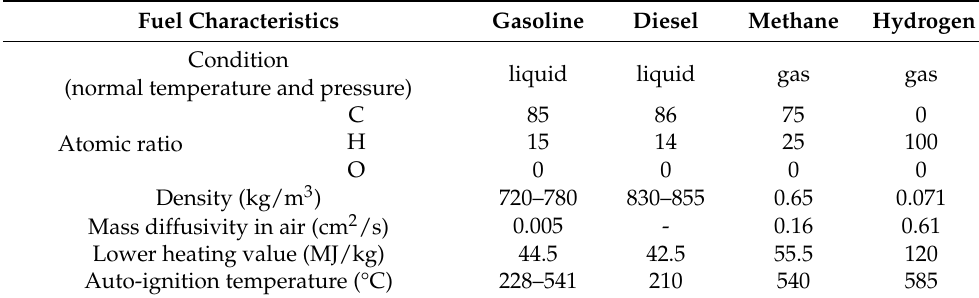
Table 1. Physical and chemical properties of the different fuels [3,5–8].